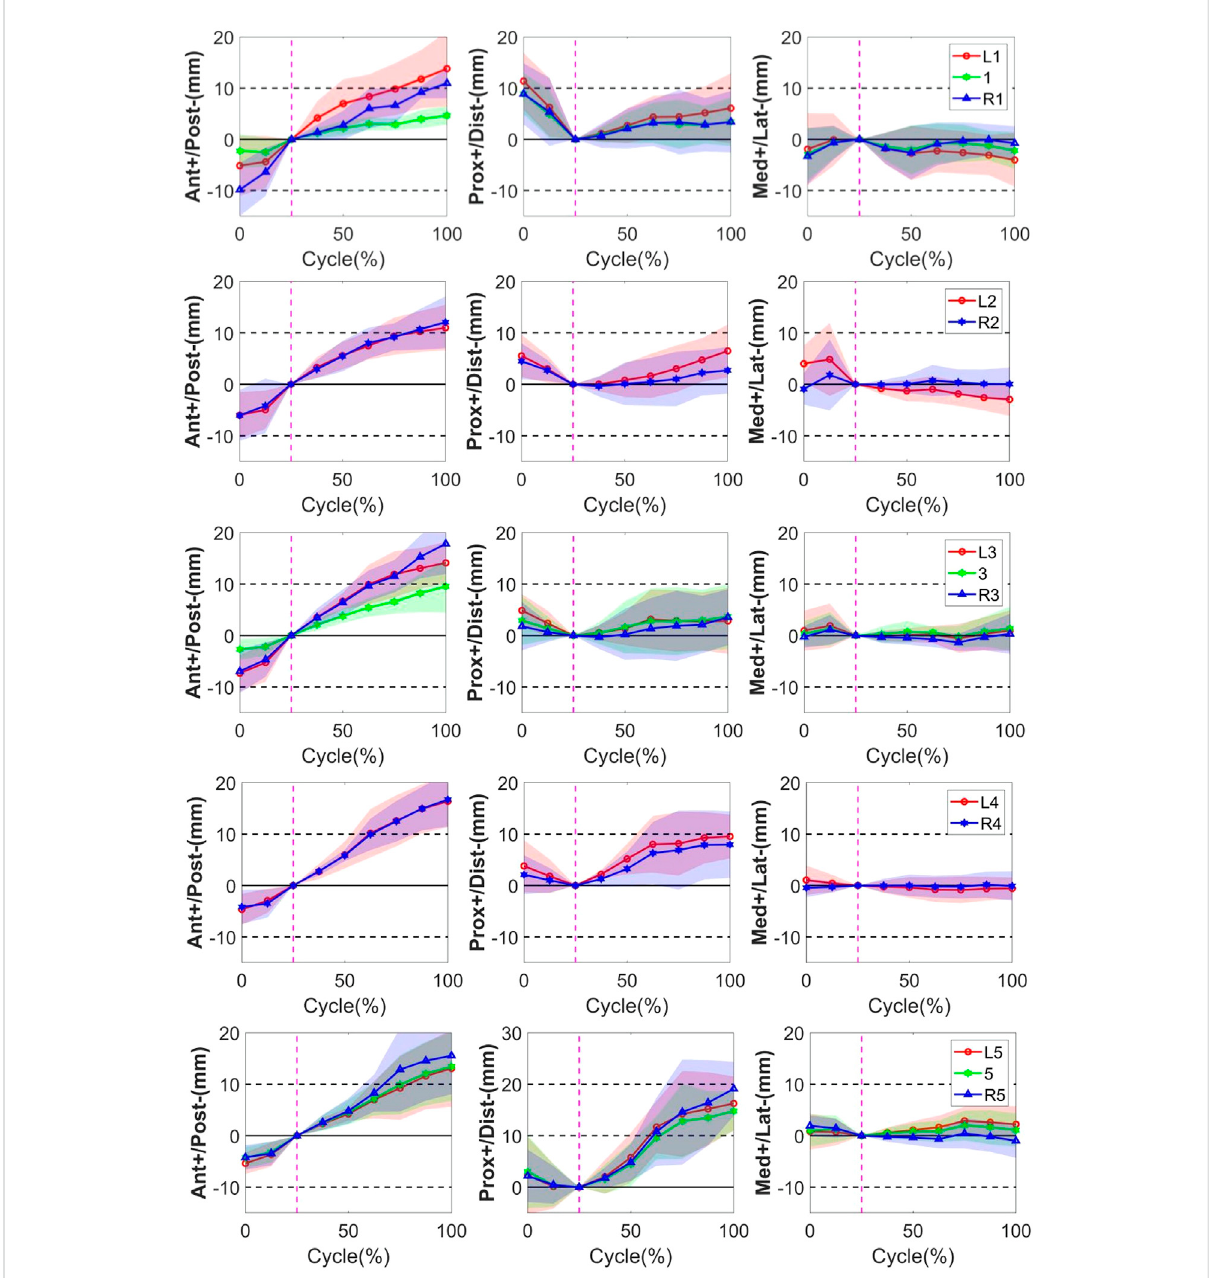
FIGURE 3 STA of the thirteen skin markers from L1 to L5 level during the bending cycle (0%, 25%, and 100% represent extension, neutral, and fl exion, respectively).ThesolidlinerepresentsthemeanSTAforallthesubjects,andtheshaded-areaerrorbandsrepresentthestandarddeviationoftheSTA. The vertical dotted line represents the neutral